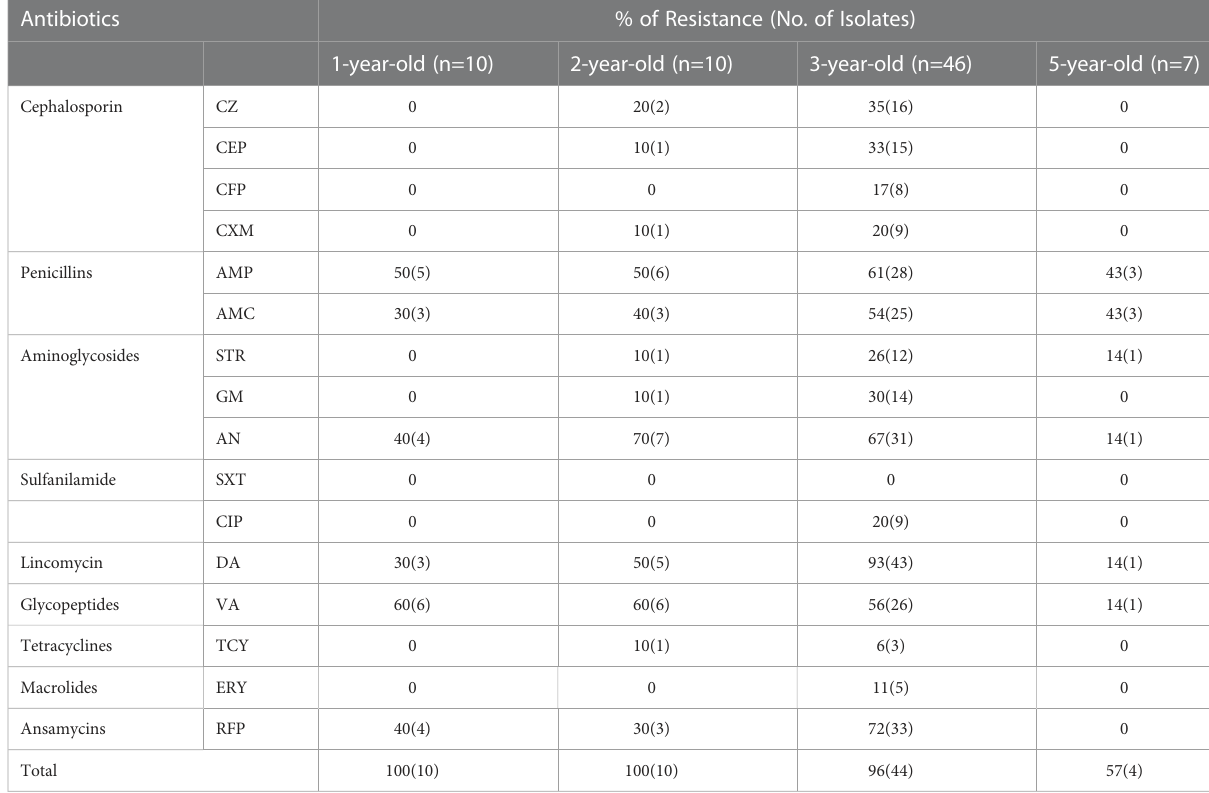
TABLE 2 Antibiotic resistance phenotypes of Vibrio isolates from Meretrix meretrix in different age. Antibiotics